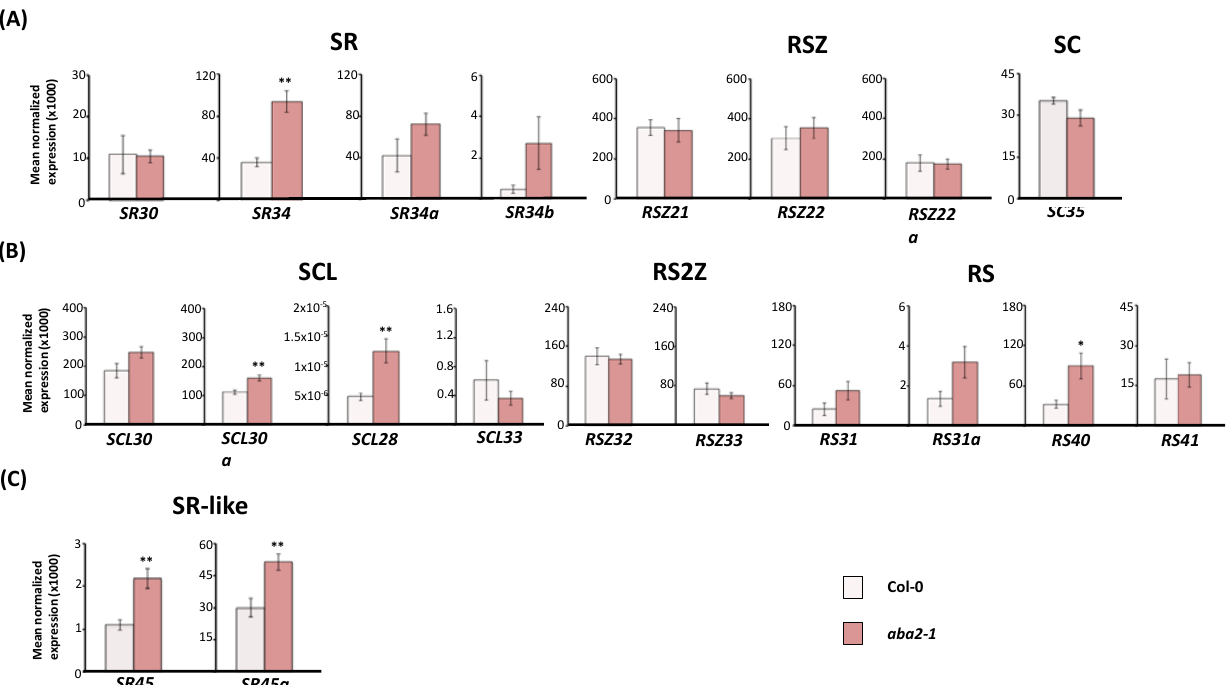
Figure 3. Expression of Arabidopsis SR and SR-like genes in the ABA-deficient aba2-1 mutant background. Real-time RT-qPCR analysis of total transcript levels of SR gene members of the mammalian ortholog ( A ) and plant-specific ( B ) subfamilies or of SR-like genes ( C ) in wild-type (Col-0) and aba2-1 mutant seedlings. Results are from two independent experiments and values represent means ± SE ( n = 4). Asterisks indicate